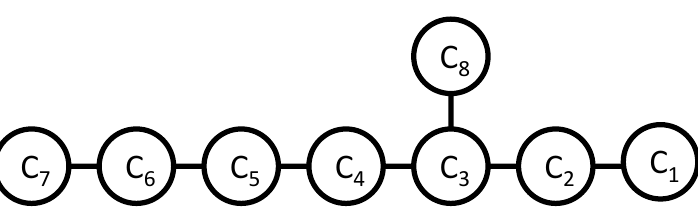
Figure 8 . The intersection structure of the curves in